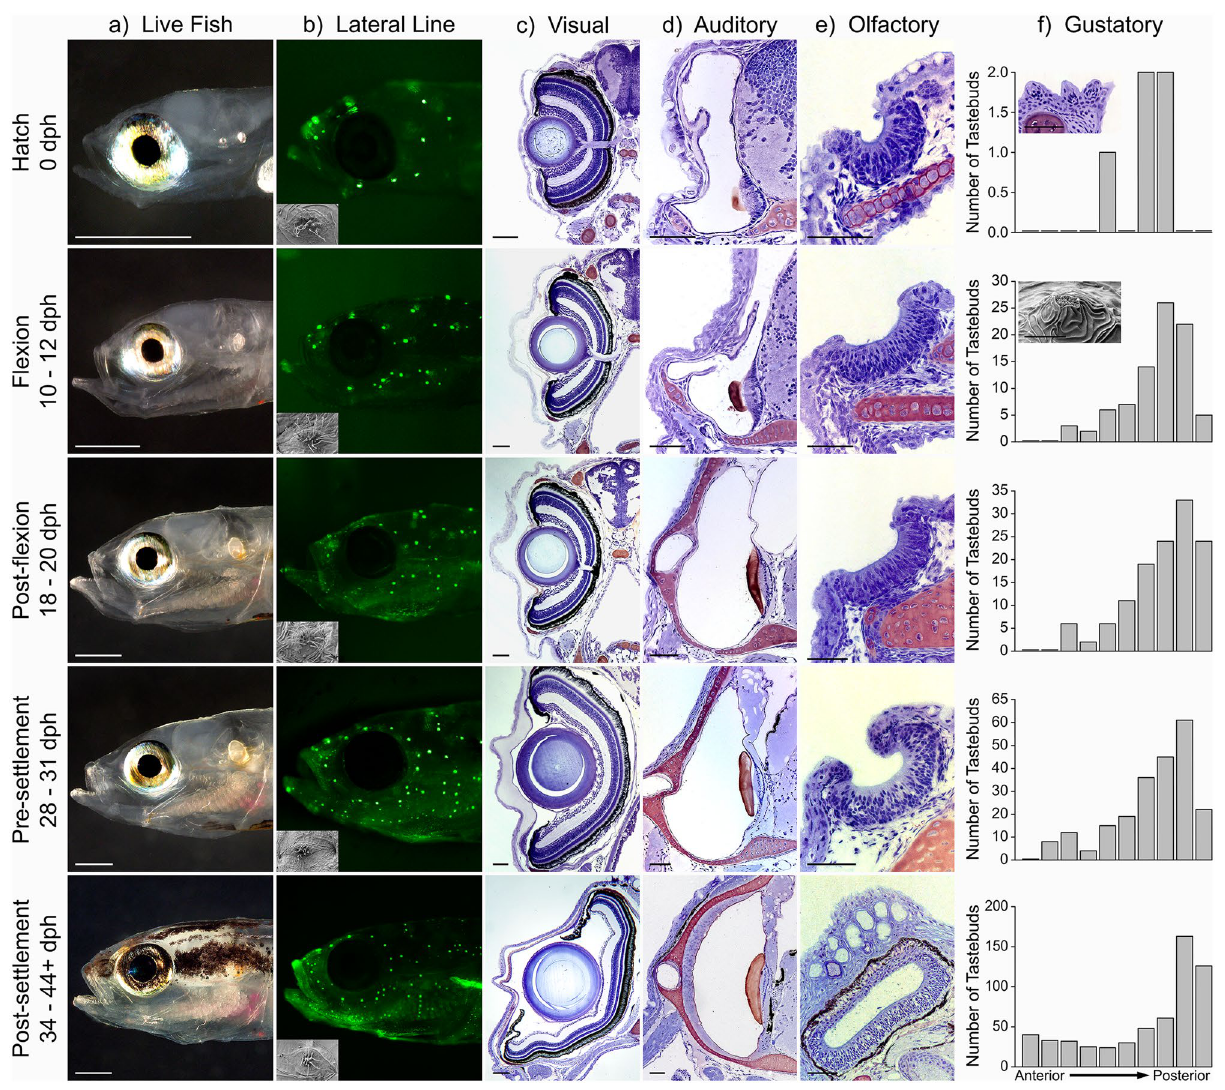
Figure 1. Development of the lateral line, visual, auditory, olfactory and gustatory sensory organs in E. lori larvae (day of hatch [0 days post-hatch (dph), 3–3.4 mm notochord length], flexion [10–12 dph, 4–5 mm standard length (SL)], post-flexion [18–20 dph, 5–7 mm SL], pre-settlement [28–31 dph, 7–9 mm SL]) and post-settlement juveniles (34–44+ dph, 9–15 mm SL) using live imaging ( a ), vital fluorescent imaging ( b ) scanning electron microscopy ( b , f insets), histology [( c )–( e ); transverse sections of whole fish; ( f ) inset] and data derived from histology ( f ). ( a ) Live larvae (0, 10, 20, 28 dph) and a post-settlement juvenile (38 dph). Note: change in the relative size of the eye, and onset of pigmentation in 34–44+ dph fish. Scale bars: 500 µm. ( b ) Neuromast receptor organs of the lateral line system in larvae, which increase in number, and are in well-defined lines in older larvae, as well as in post-settlement juveniles, in which a small number of neuromasts above the eye and on the cheek will be enclosed in pored lateral line canals. Insets illustrate the morphology of neuromasts, which take on a diamond-shape; hair cells (ciliated) located in the central region of the neuromast. The elongated gelatinous cupula in which cilia of hair cells are embedded was removed during preparation to visualize the hair cells. ( c ) A prominent, well-developed eye is present at hatch and is already comprised of a multilayered retina (layers increase in thickness at different rates through the larval phase), a spherical lens, and a cornea (0–30 dph); the optic nerve is visible in images of 0–20 dph fish, but is out of the plane of section in the 28–44+ dph fish. Note: corneal thickness in the 28–31 dph fish is a preparation artifact. Scale bars = 50 µm. ( d ) Inner ear is present at hatch (0 dph). The sensory epithelium of the sacculus (the largest of the three otolithic organs, the other two not visible in plane of section) is located on the vertical wall (lateral to the hindbrain) at all stages; it is overlaid by a calcareous otolith (otolith remnant is dark pink). The horizontal semicircular canal (one of the three semicircular canals) is well-formed by 18–20 dph; it is visible in cross section at the lateral edge of the cartilaginous neurocranium (dark pink). Scale bars = 50 µm. Note: otoliths (especially the large saccular otolith) are visible in live larvae [( a ) 0–31 dph] but are obscured by pigment in post-settlement juveniles (34–44+ dph). ( e ) The olfactory organ is a patch of ciliated olfactory neurons (cilia not visible at this resolution) on the surface of the “snout” at hatch; it gradually invaginates and increases in length and width during the larval stage, and is enclosed in a blind sac with two nares (not in plane of section) in post-settlement juveniles. ( f ) Internal taste buds are present at hatch in the posterior half of the oral cavity (including the gill arches); their number increases (note Y-axis values) and their distribution expands anteriorly to occupy all internal surfaces of the oral cavity and the surface of the lips. Insets: top—three taste buds on gill arch (Scale bar = 50 µm); bottom—one taste bud (just behind the teeth of the lower jaw) showing microvilli at the tips of the sensory cells that comprise the taste bud, which is surrounded by general epithelium (Scale bar = 5 µm). Some images have been transposed (left to right), or partially rotated for uniformity. See text and SI Table 1 for additional